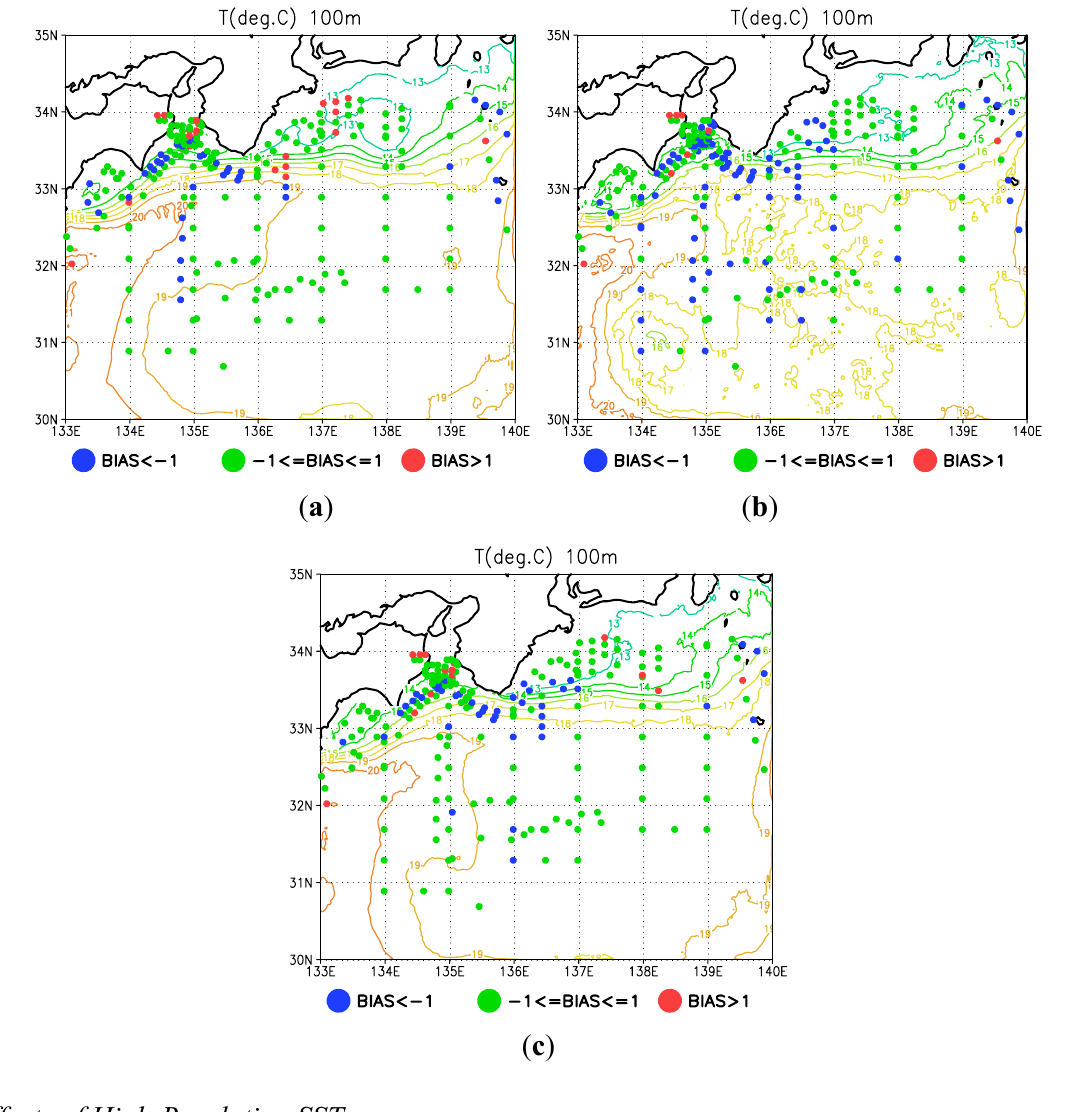
Figure 3. Contours indicate temperature at 100 m depth averaged for the period from 8 to 28 February 2010. Closed circles denote all positions of the in situ observations in which numbers were larger than 4 and their colors indicate mean error (bias) between the reproduced and observed in situ profiles. ( a ) NO-MODIS. ( b ) mqc. ( c )